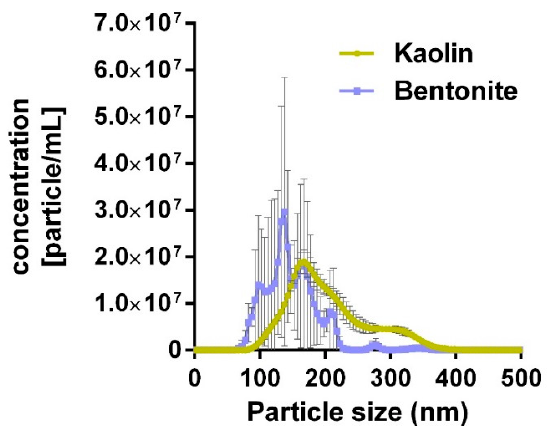
single measurements.